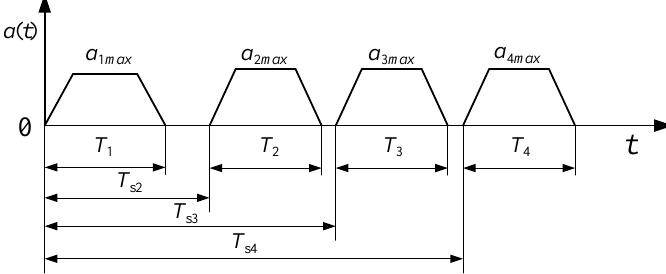
Figure 2. Starting acceleration curve for AMT.